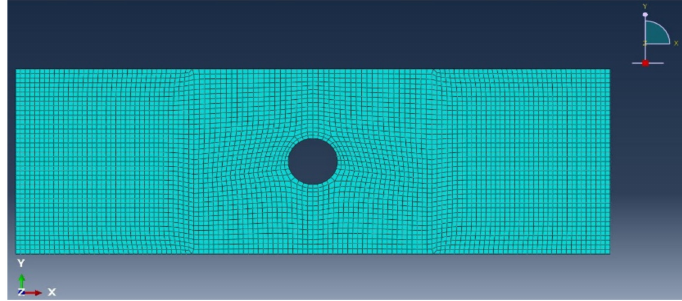
Figure 8. An example of the FGM plate meshing in